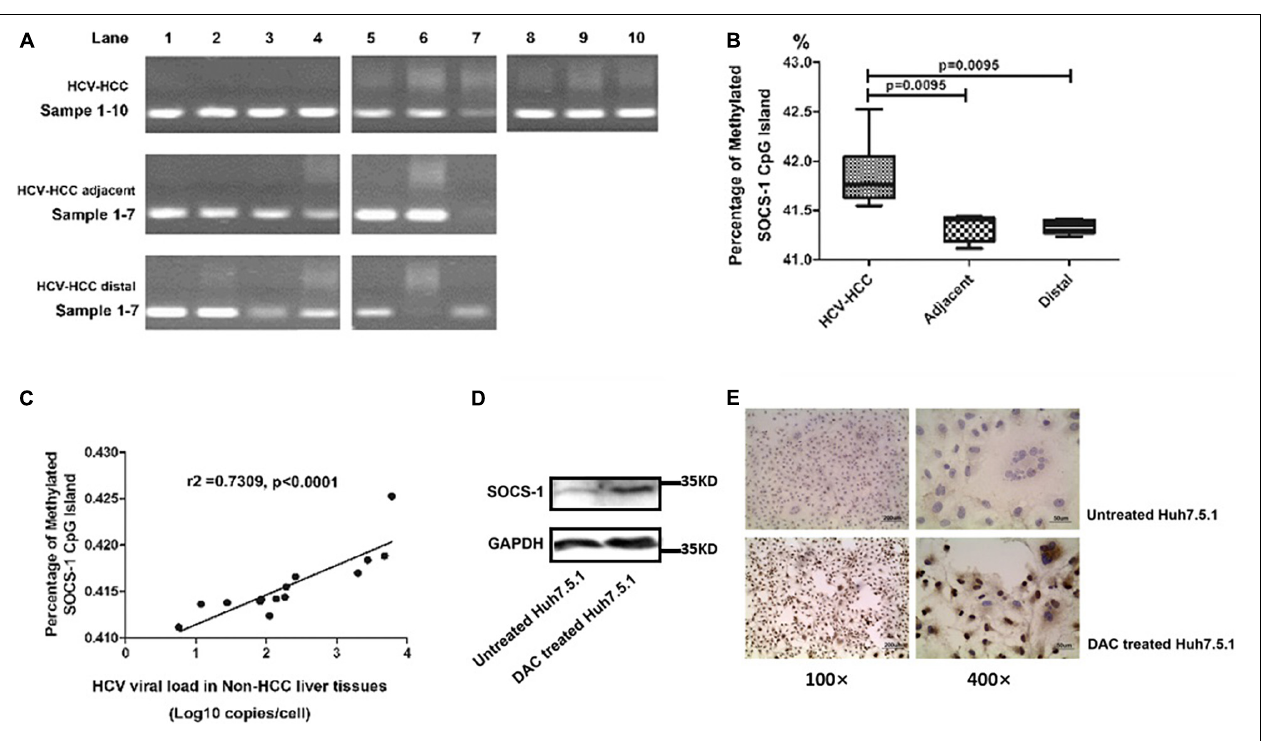
FIGURE 5 | The methylation of the CpG island in the SOCS-1 gene promoter affects SOCS-1 expression in tissues and cell lines. (A) The methylation of the CpG island in SOCS-1 gene promoter in HCV-HCC tissues and related tissues. (B) The statistical diagram of the methylation of the CpG island in SOCS-1 gene promoter in three kinds of tissues. (C) The correlation between SOCS-1 gene methylation and HCV viral load in non-HCC liver tissues. (D) The Western blot of SOCS-1 expression in HCVcc-infected Huh7.5.1 cells treated by DAC. (E) The ICC image of SOCS-1 expression in HCVcc-infected Huh7.5.1 cells treated by DAC (Mann–Whitney U